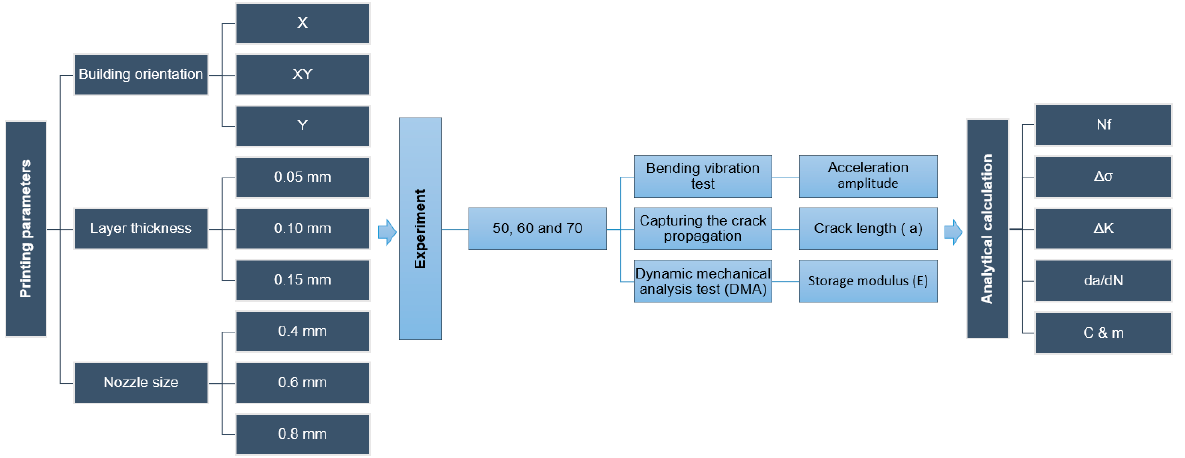
Figure 6. Detailed experiment scheme.